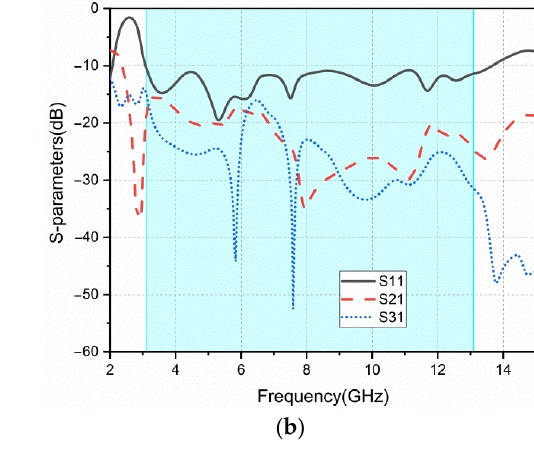
Figure 5. ant5: ( a ) geometry; ( b ) S-parameters.